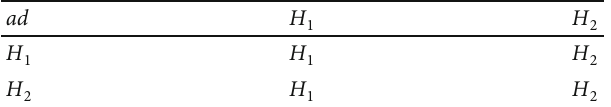
Table 2: Adjoint